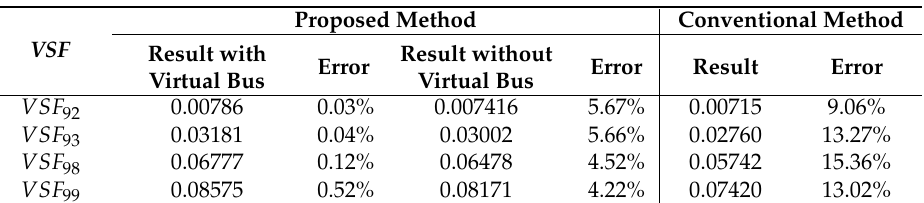
Table 6. The computation results for case 2 for DER control in the proposed and conventional methods during heavier loading condition (L2).